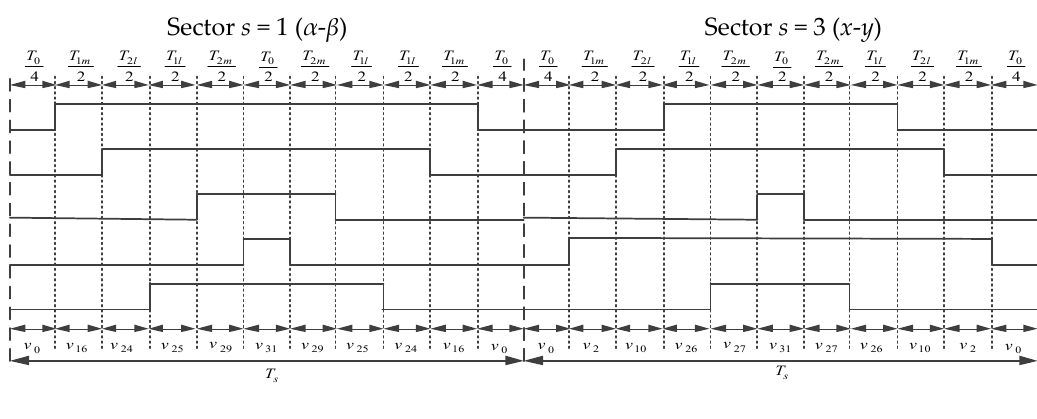
Figure 6. Switching pattern obtained with SVM.